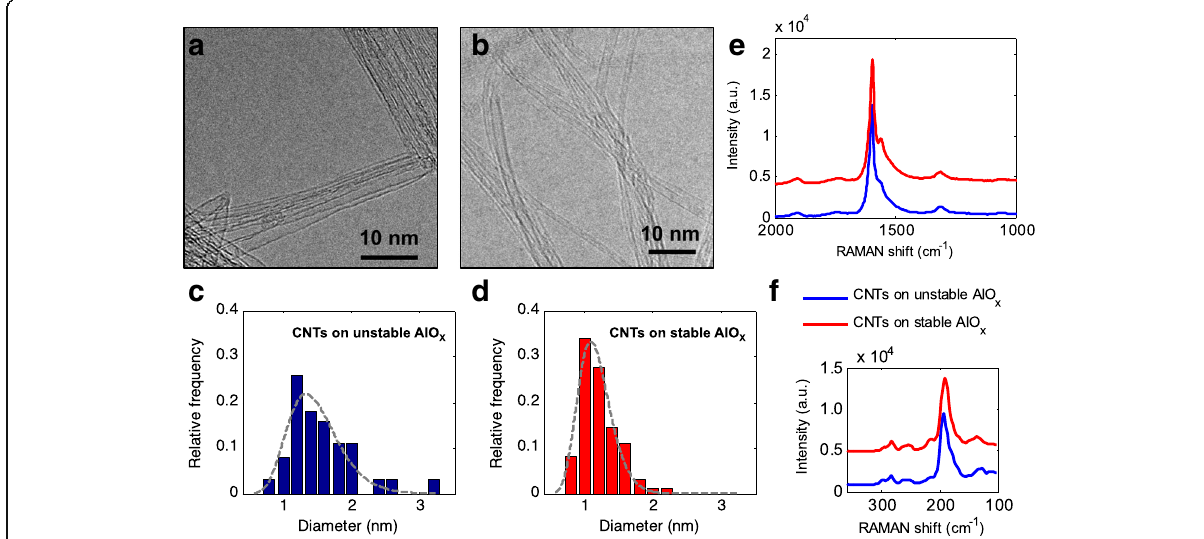
Fig. 4 a , b TEM images of CNTs grown on alumina deposited by a nonreactive sputtering and b reactive sputtering. CNTs grew from the catalyst with different diameter distributions; histograms ( c ) and ( d ) result from analysis of many images such as ( a ) and ( b ), respectively. The mean diameters of c and d are approximately 1.4 and 1.2 nm, respectively. e , f Raman spectra (excitation at 632.8 nm) collected from the top of the produced nanotube forests. The red (upper) curve indicates the Raman spectrum from CNTs on the stable alumina, and the blue (lower) curve